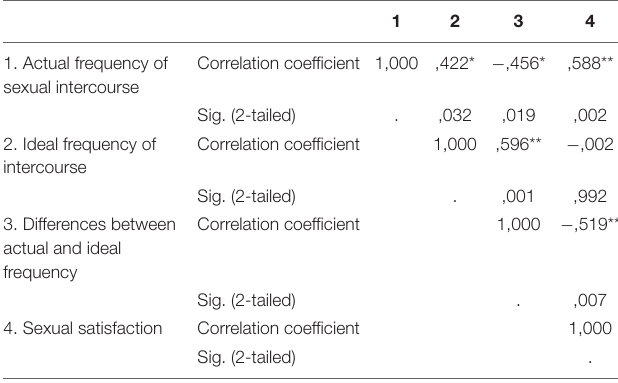
TABLE 4 | Correlation between the variables of the DSFI (couples).